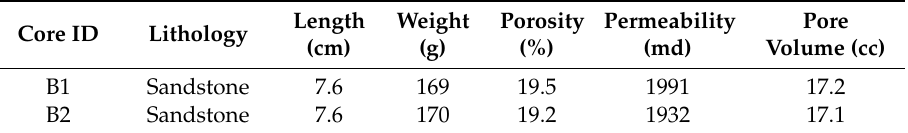
Table 1. Core Sample Properties.